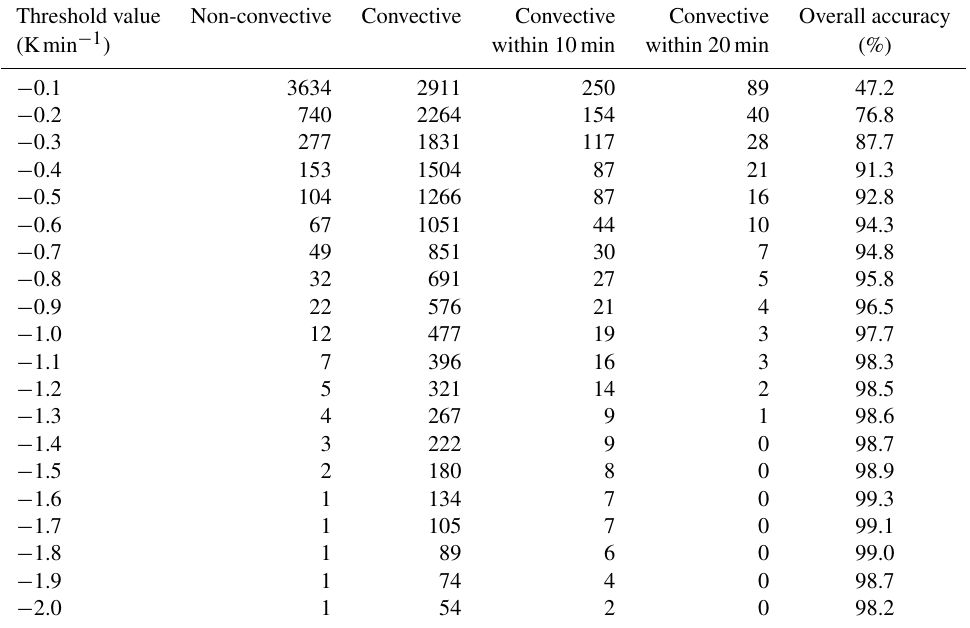
Table 1. Number of non-convective, convective, convective within 10min, and convective within 20min for using different threshold values (Channel 8).